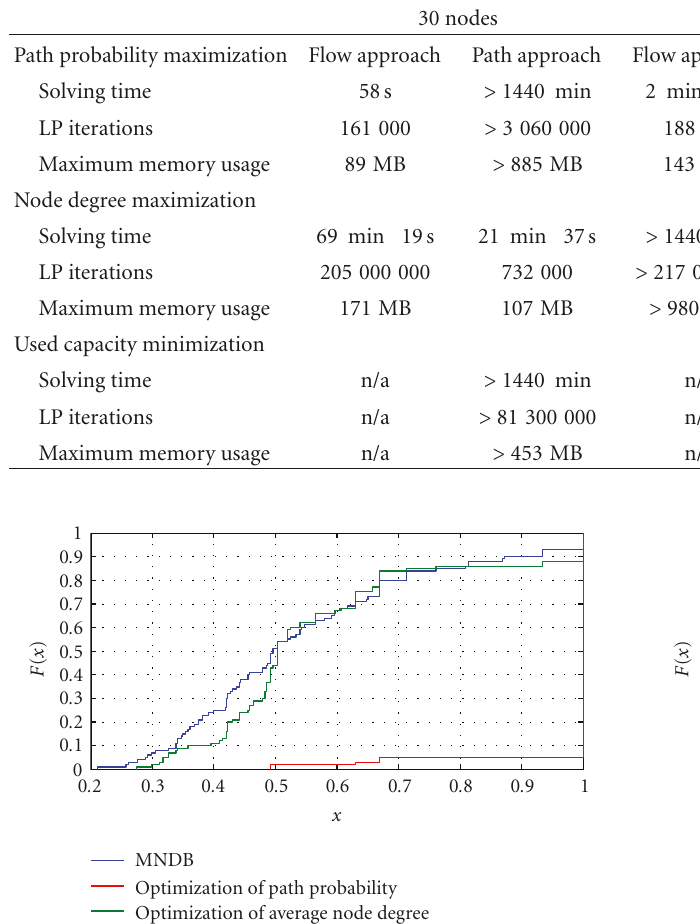
Table 1: Performance data.